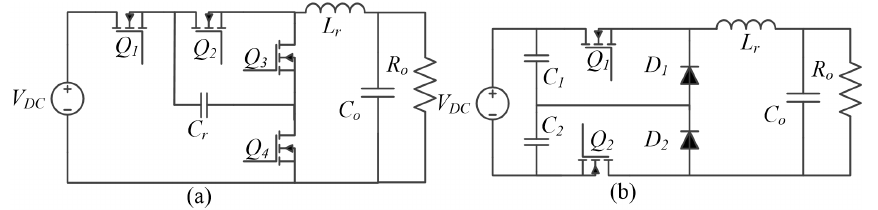
Figure 8. Different realizations of three-level buck converter; ( a ) basic, and ( b ) improved